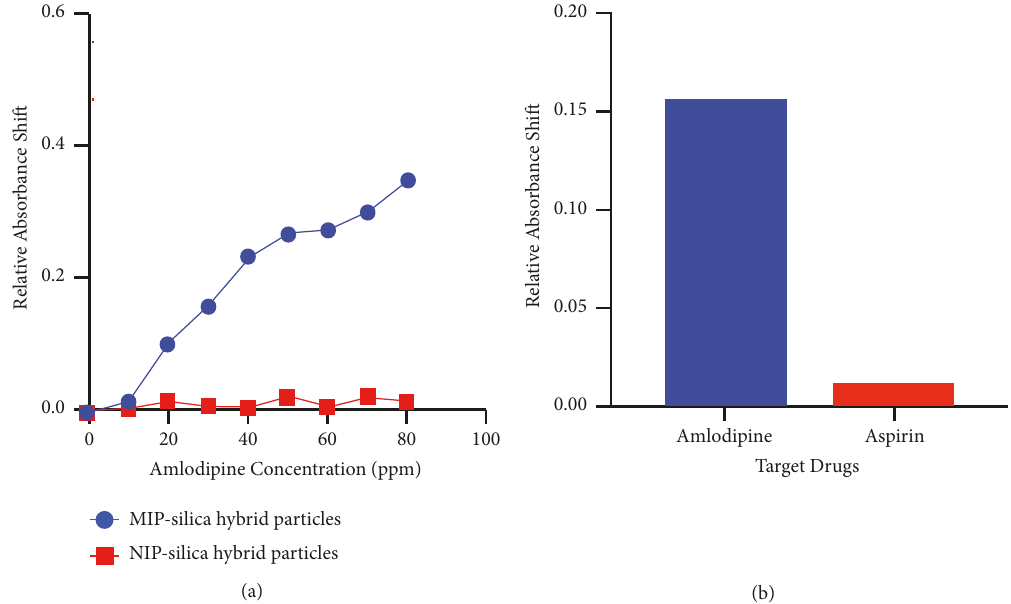
Figure 4: (a) A comparison of the relative absorbance shifts of standard amlodipine solution treated with MIP-silica and NIP-silica hybrid particles, respectively, while (b) shows the relative absorbance shifts for amlodipine and aspirin drugs after treatment with MIP-silica hybrid particles: The greater absorbance shift for amlodipine represents selectivity of the